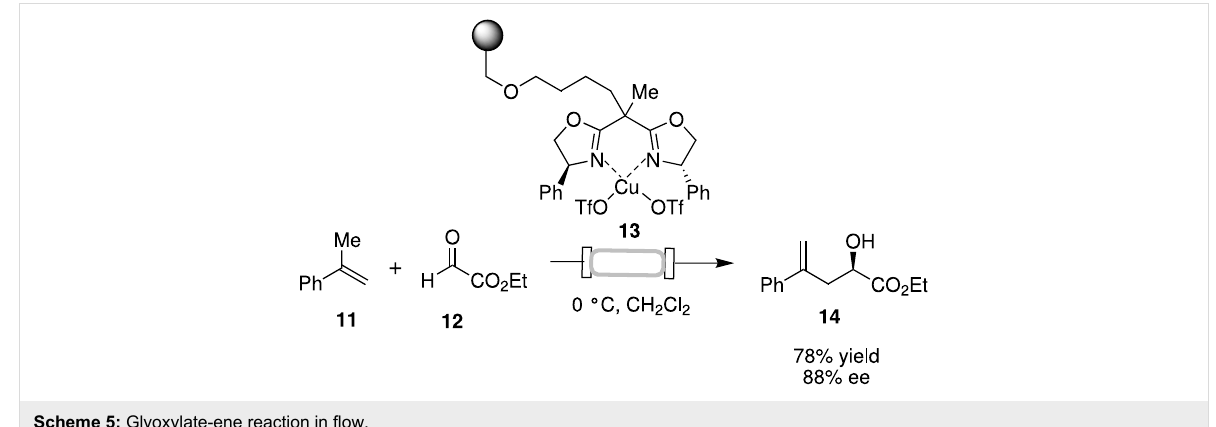
Scheme 5: Glyoxylate-ene reaction in